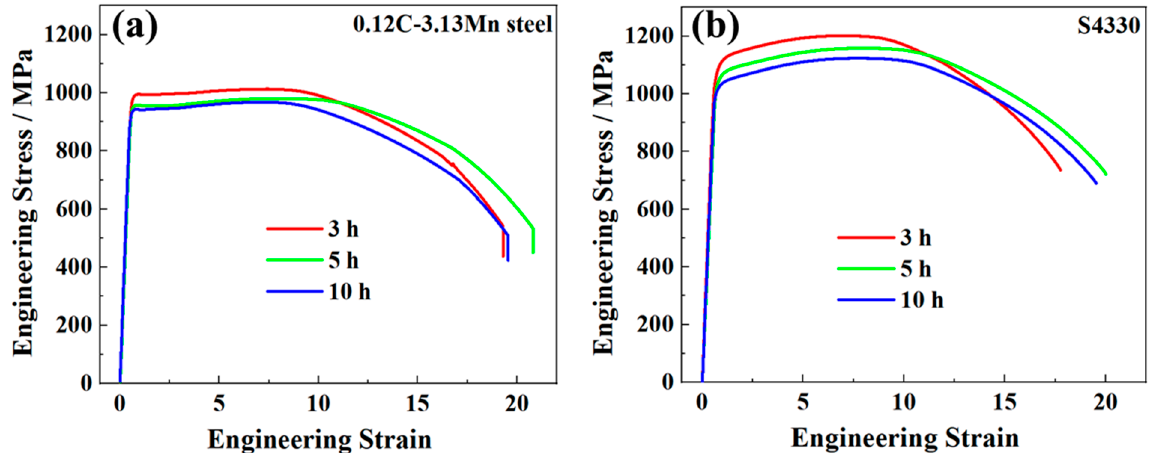
Figure 2. Engineering strain and stress curves of ( a ) 0.12C-3.13Mn steel and ( b ) S4330 steel. Both the tensile strength (TS) and yield strength (YS) decreased as the tempering time increased. From Figure 3a, the TS and YS of S4330 steel are about 150 MPa and 100 MPa